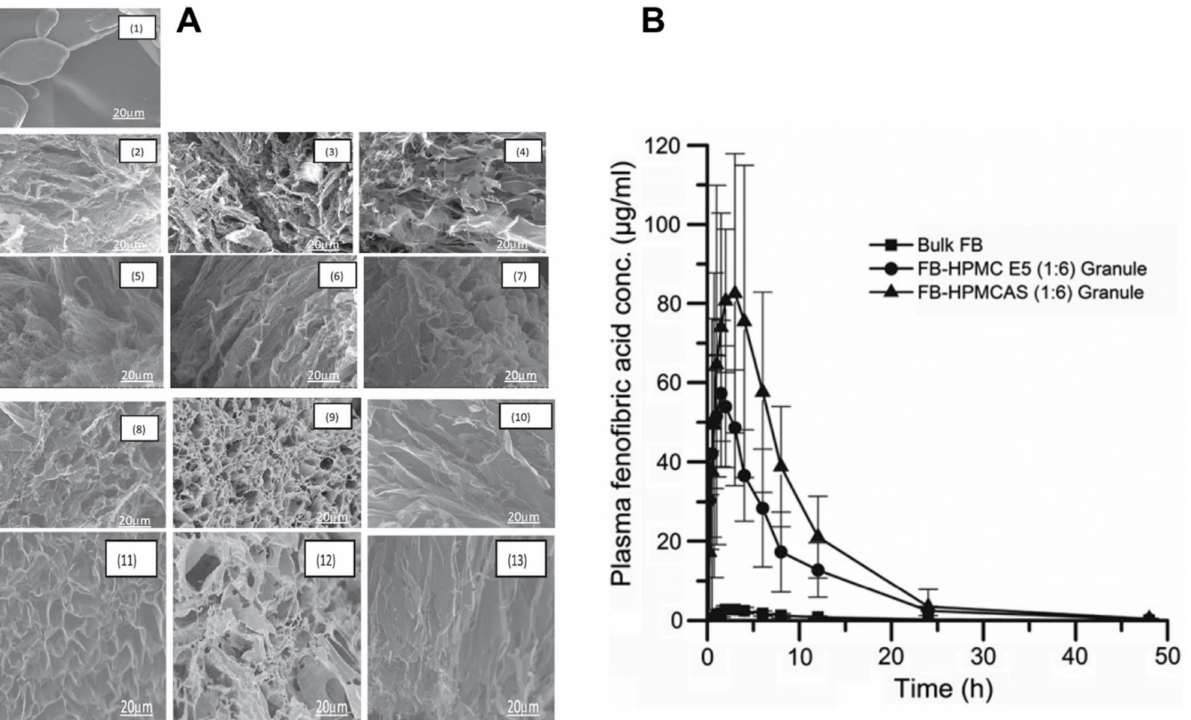
Figure 5. ( A ) SEM micrographs of bulk FB and FB solid dispersions prepared by the TFF process. (1) Bulk FB; (2) FB-Soluplus (1:4); (3) FB-Soluplus (1:6); (4) FB-Soluplus (1:8); (5) FBHPMC E5 (1:4); (6) FB-HPMC E5 = 1:6; (7) FB-HPMC E5 = 1:8; (8) FB-HPMCAS (1:4); (9) FB-HPMCAS (1:6); (10) FB- HPMCAS (1:8); (11) FB-HP55 (1:4); (12) FB-HP55 (1:6); and (13) FB- HP55 (1:8); and ( B ) Average plasma-drug concentration of fenofibric acid following single-dose oral administration of different formulations to Wistar rats (data presented are mean ± SD, n = 6, dose is 27 mg/kg). Reproduced from Zhang et al. [3] with kind permission of copyright holder,